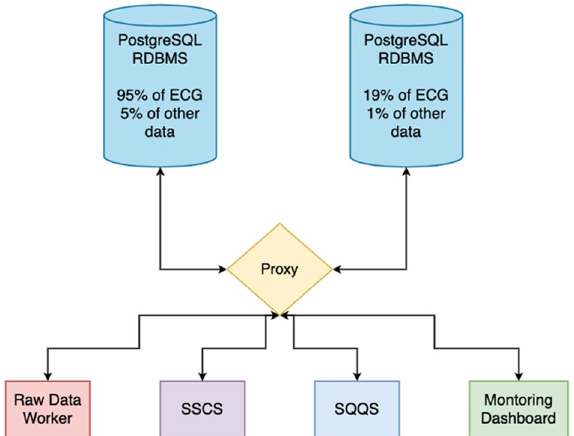
Fig. 13 The proposed system with two split databases